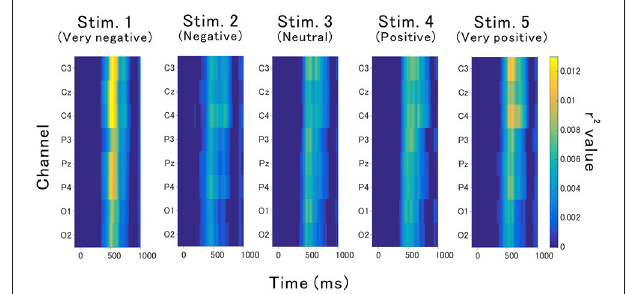
TABLE 2 | The 99% confidence intervals of valence estimated by Scheffe method. Stimulus pair